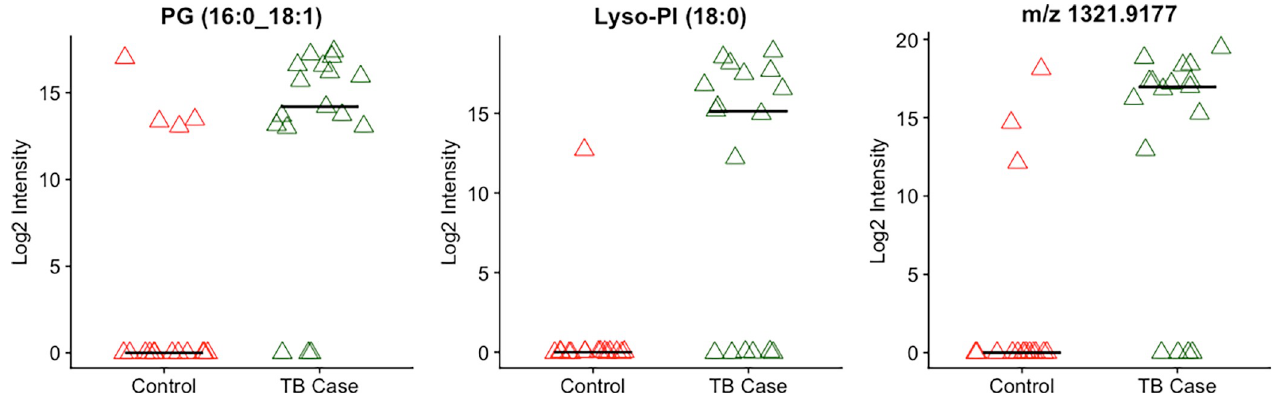
Fig 2. Three most significant Mtb lipid matches in plasma. Intensity values of the Mtb -associated metabolites phosphatidylglycerol (PG) (16:0_18:1) and lysophosphatidylinositol (Lyso-PI) (18:0), as well as m/z 1321.9177 [each p < 0.001; active TB cases (green triangles) vs household contacts (red triangles)]. m/z 1321.9177 was predicted as acylphosphatidylinositol mannoside (Ac1PIM1) (56:1) based on accurate mass and retention time measurements, but could not be confirmed using tandem MS/MS. Line depicts median values for each subject cohort.